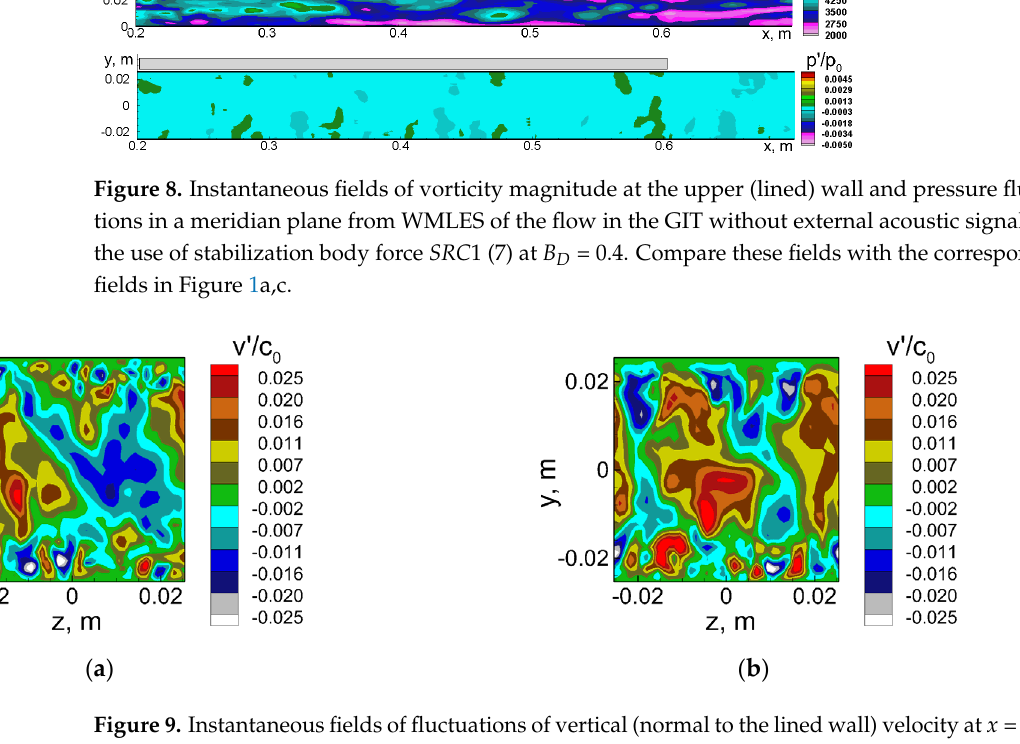
Figure 10. Comparison of wall-pressure spectra at x = 0.6 m predicted by WMLES of three fl ows. Green: duct with solid walls, original equations; red: duct with liner, original equations; blue: duct with liner, equations with added stabilization body force SRC1 (7) at B D = 0.4. ( a ) ( b ) Figure 11. Same as in Figure 10, for streamwise distributions of root-mean-square wall-pressure fl uctuations ( a ) and mean friction coe ffi cient ( b ).